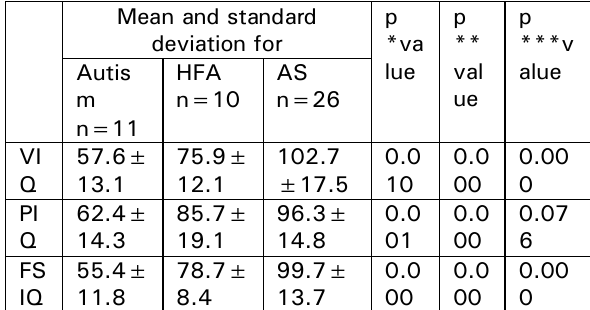
Table 1: VIQ, PIQ and FSIQ in different children group Mean and standard deviation for